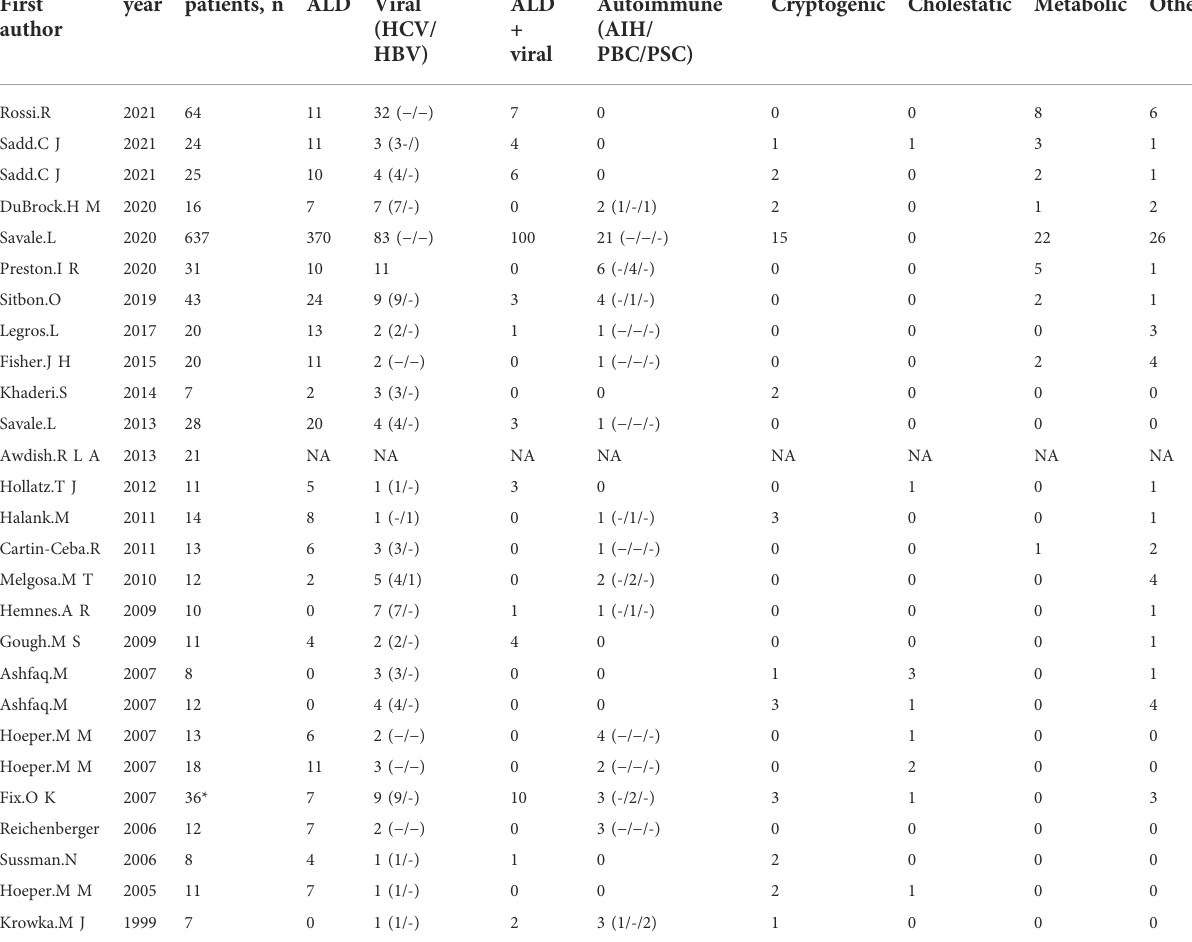
TABLE 2 Characteristics of the 27 Included Studies: etiology of liver